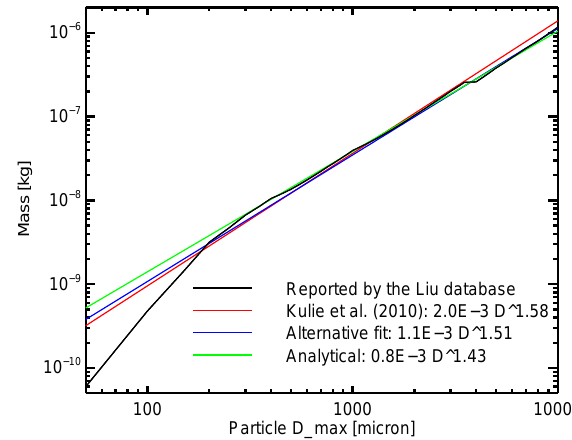
Figure B1. Particle mass as a function of size for the Liu sector snowflake. The x axis scale is in microns for convenience but the fits reported on the legend are based on SI